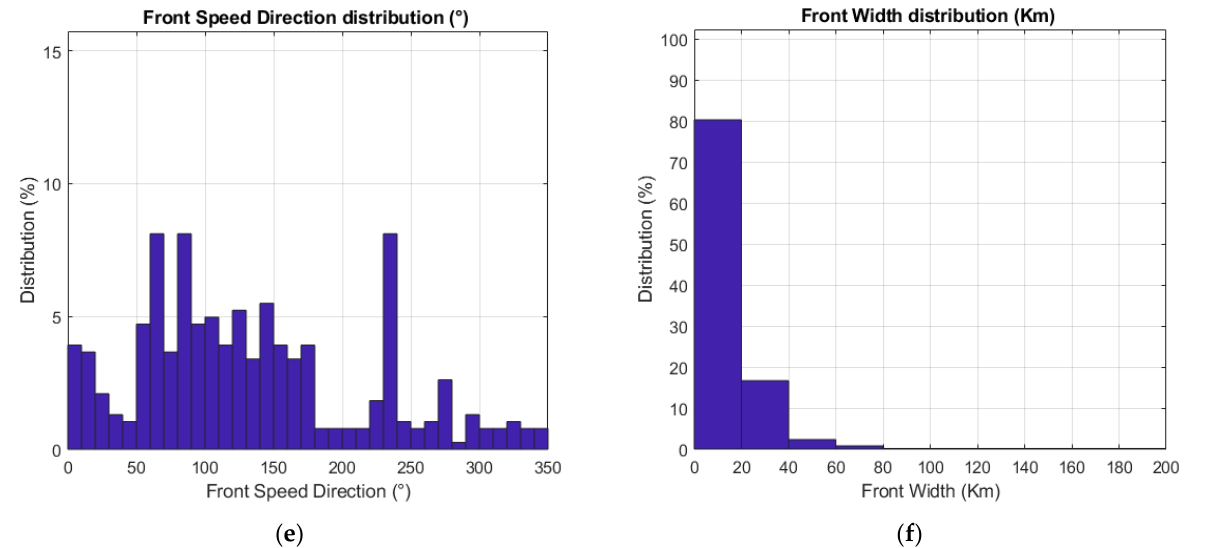
Figure 4. ( a ) Distribution of the ionospheric spatial gradient observations.; ( b ) Ionospheric spatial gradient distribution per hour of day (local time); ( c ) Ionospheric spatial gradient distribution as a function of satellite elevation; ( d ) Scatterplot of the ionospheric spatial gradient and satellite elevation; ( e ) Ionosphere front direction of motion distribution; ( f ) Ionospheric front width distribution.